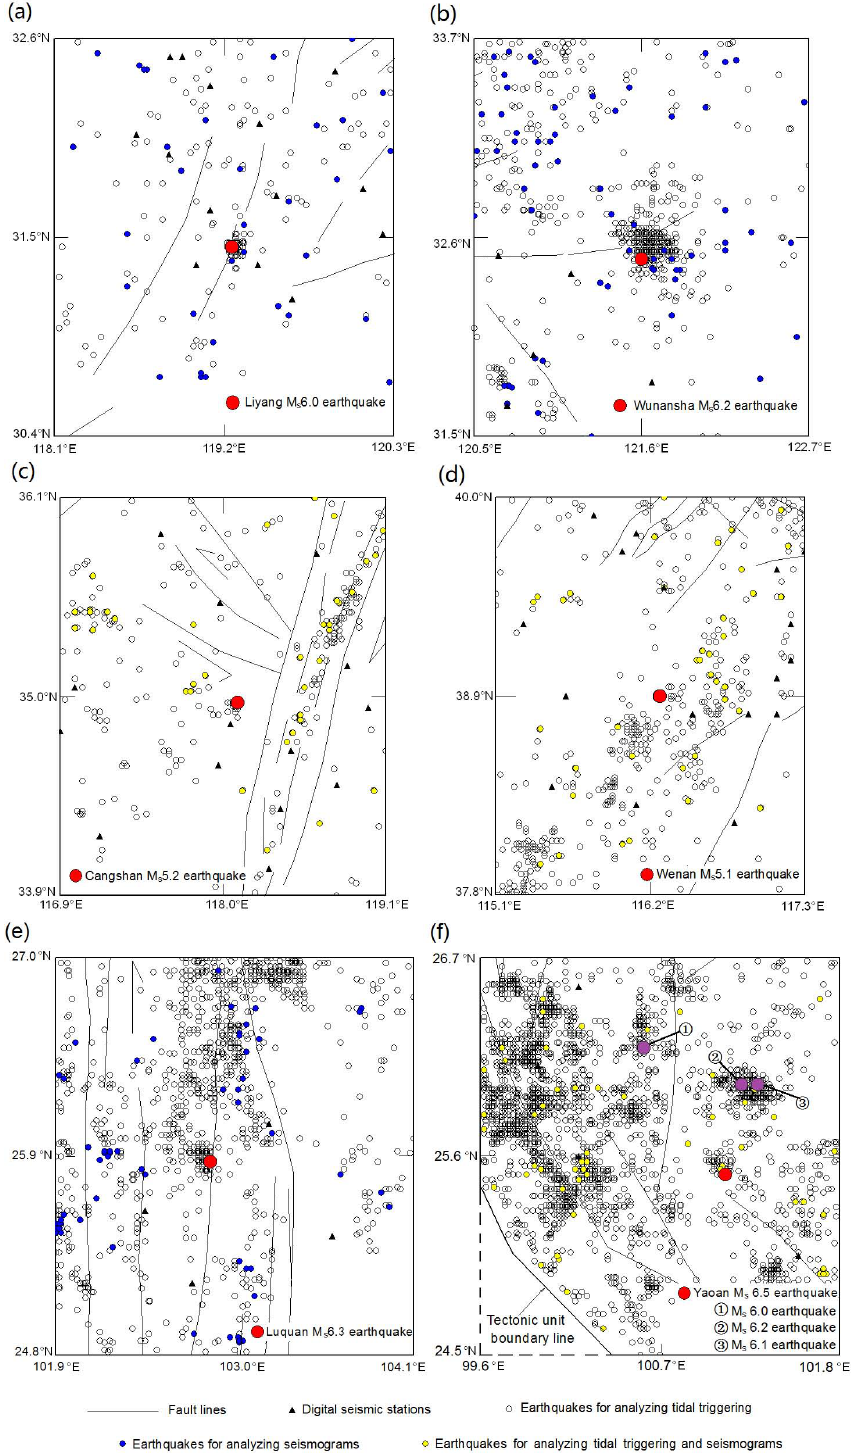
Fig. 4. The distribution of the seismic events (the mean location uncertainty of these events is 5km), fault lines and digital seismic stations. The blue dots indicate the earthquakes for analyzing seismograms, and the yellow dots indicate the earthquakes for analyzing tidal triggering and seismograms. (a) Liyang region. (b) Wunansha region. (c) Cangshan region. (d) Wenan region. (e) Luquan region. (f) Yaoan region. In the Liyang region, there is a fault zone named Maoshan fault zone. In the Cangshan region, there is a large fault zone named Tanlu fault zone. In the Luquan region, there is a large fault zone named Xiaojiang fault zone. In the Yaoan region, there is a fault zone named Chuxiong- Jianshui fault